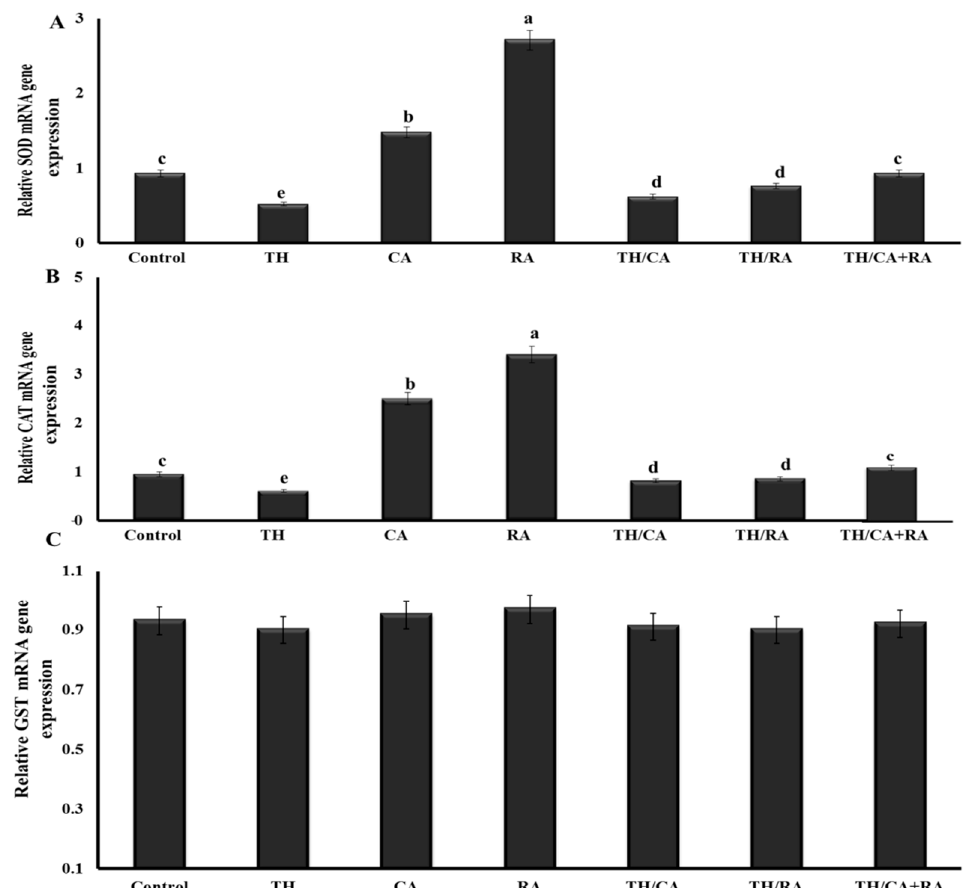
Figure 2. Effect of thiacloprid (TH), chicoric (CA), and rosmarinic acids (RA) in ovo exposure on the expression pattern of antioxidant ‐ related genes ( A ) SOD, ( B ) CAT, and ( C ) GST ‐α in the brain of 19 ‐ day ‐ old chicken embryos. Values are mean ± SEM, bars that are not sharing a common superscript letter (a–d) differ significantly at p < 0.05.